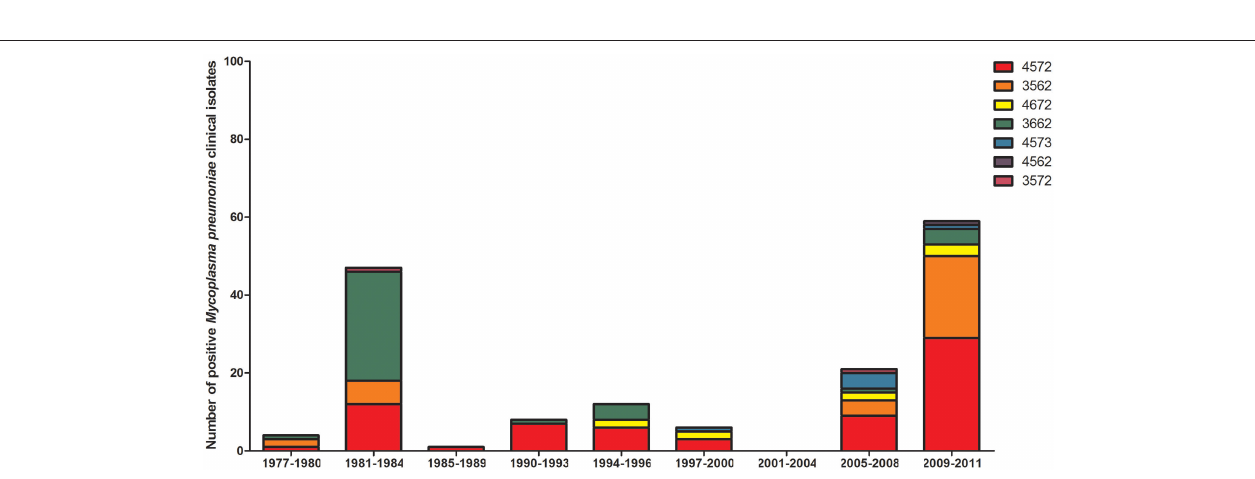
FIGURE 4 | Distribution of MLVA types in positive M. pneumoniae clinical specimens/isolates collated into the 4-yearly epidemic cycles observed in the UK. Year groups indicative of epidemic periods are listed on the x -axis. MLVA profiles are listed in the key and indicated with differing